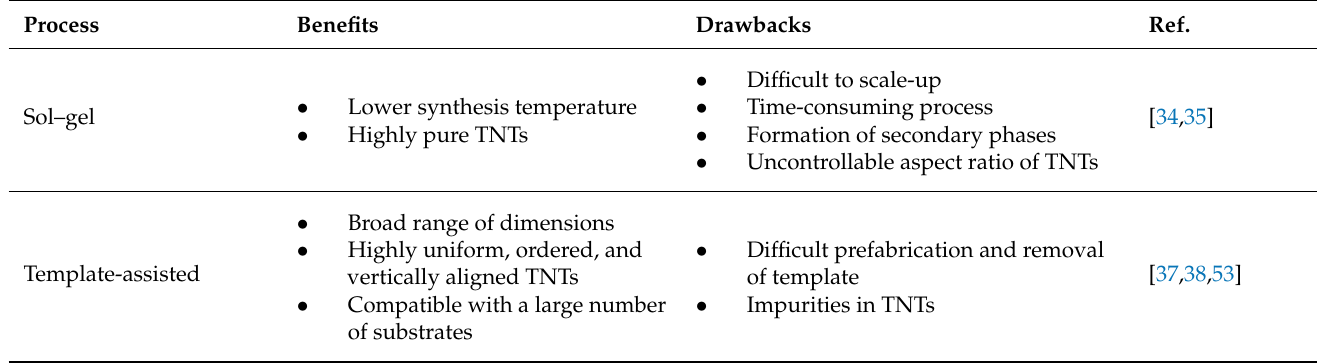
Table 1. Comparison of various fabrication processes for